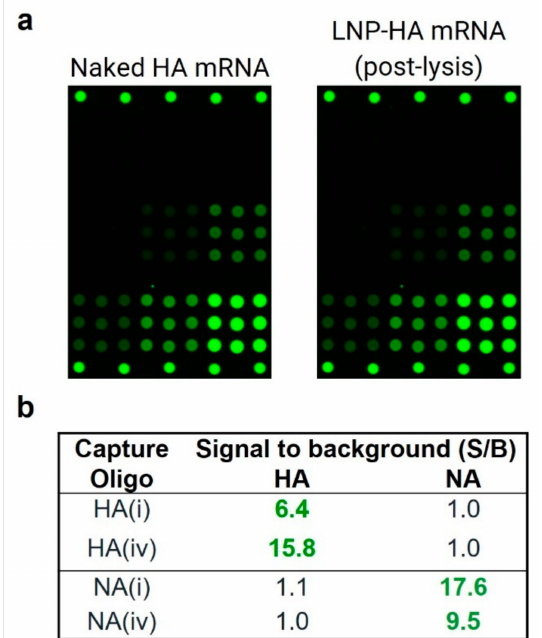
Figure 5. ( a ) Representative fluorescence images comparing naked (unencapsulated) HA mRNA and LNP-encapsulated mRNA post-lysis, both at 2 µ g/mL and imaged at the same exposure time. ( b ) Signal/background (S/B) for monovalent LNP-encapsulated HA and NA mRNA post-lysis at 5 µ g/mL. Text in bold green highlights S/B >